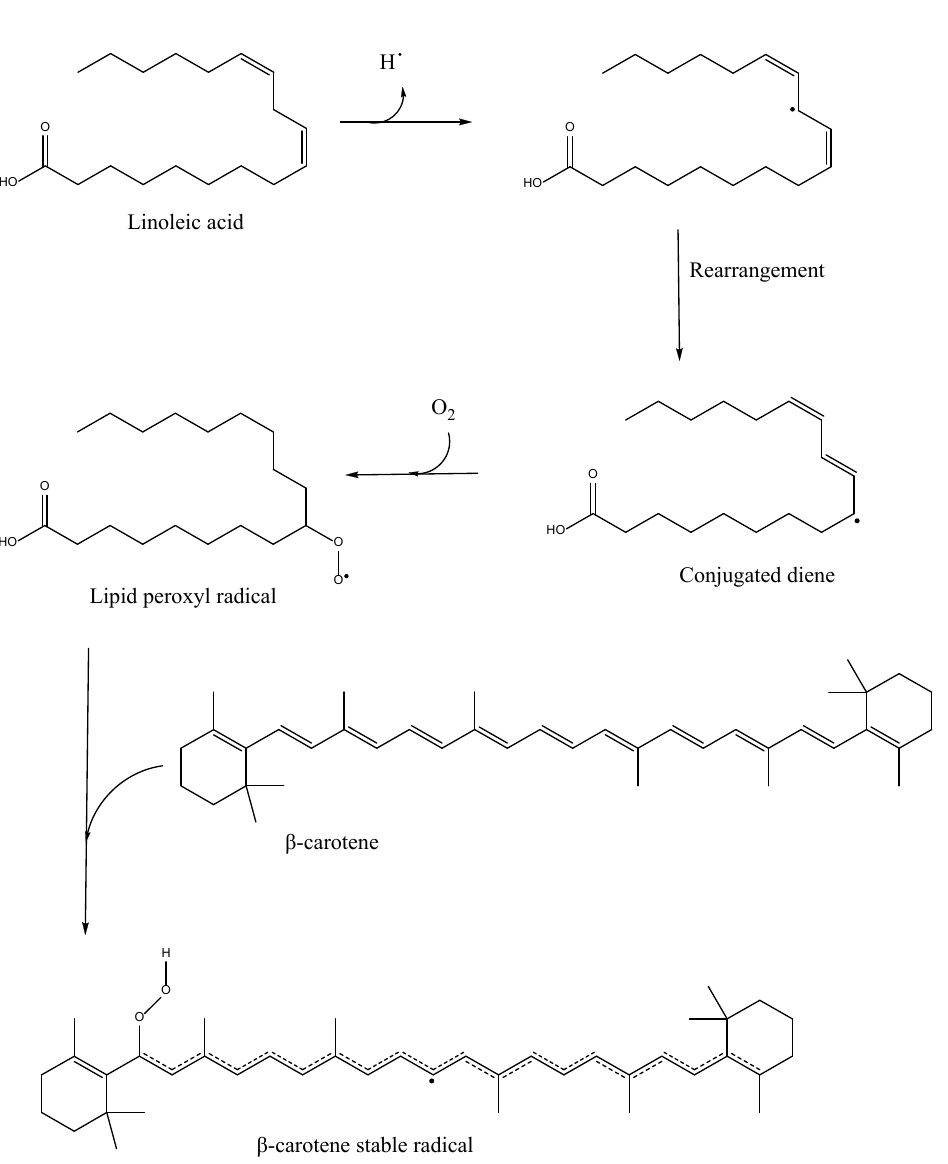
Figure 12. β -carotene stabilization mechanism [58].